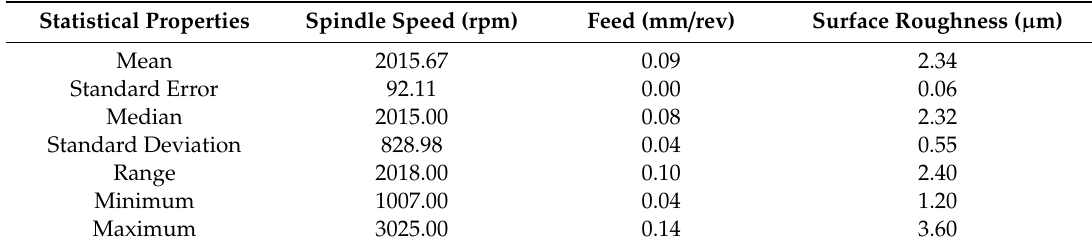
Table 4. Statistical properties of experimental database.